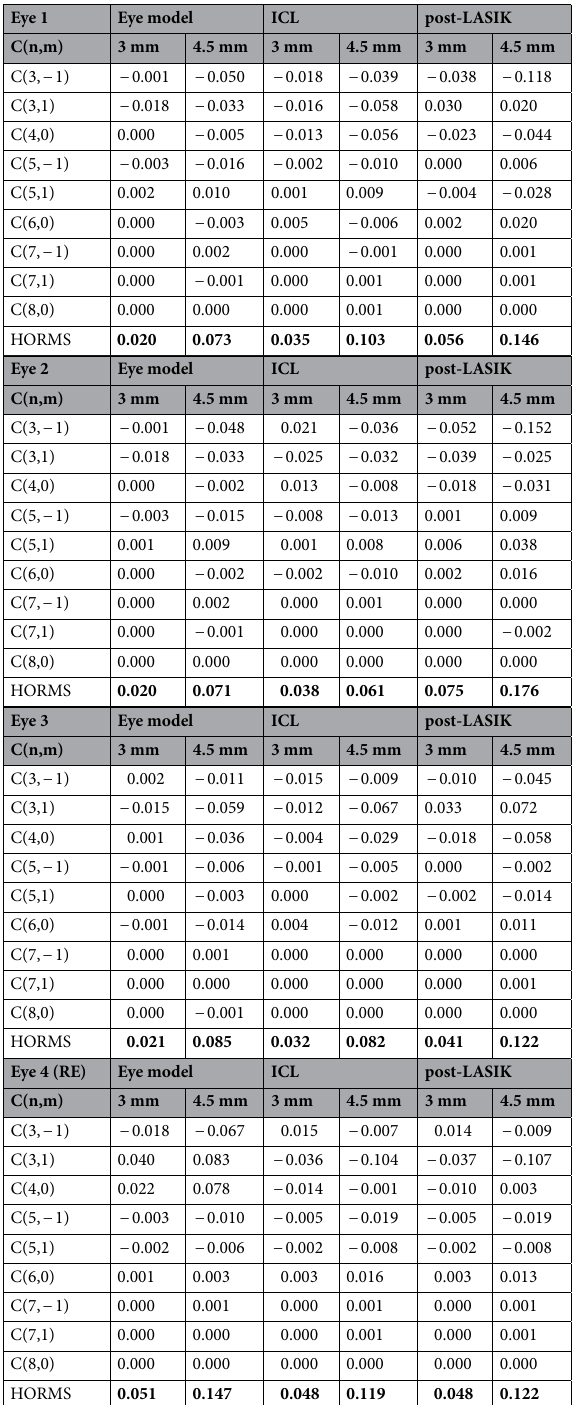
Table 4. Spherical-like and coma- like Zernike coefficients of the four eyes for the eye model as well as for the ICL implantation and the post-LASIK surgery simulations. High Order RMS aberrations (HORMS) were calculated onsidering the Zernike coefficients from the third to eighth